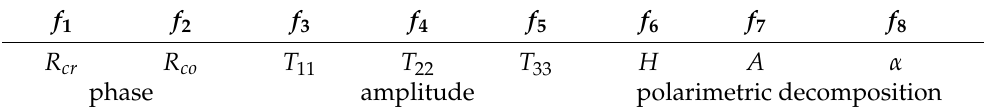
Table 1. The polarimetric feature set.